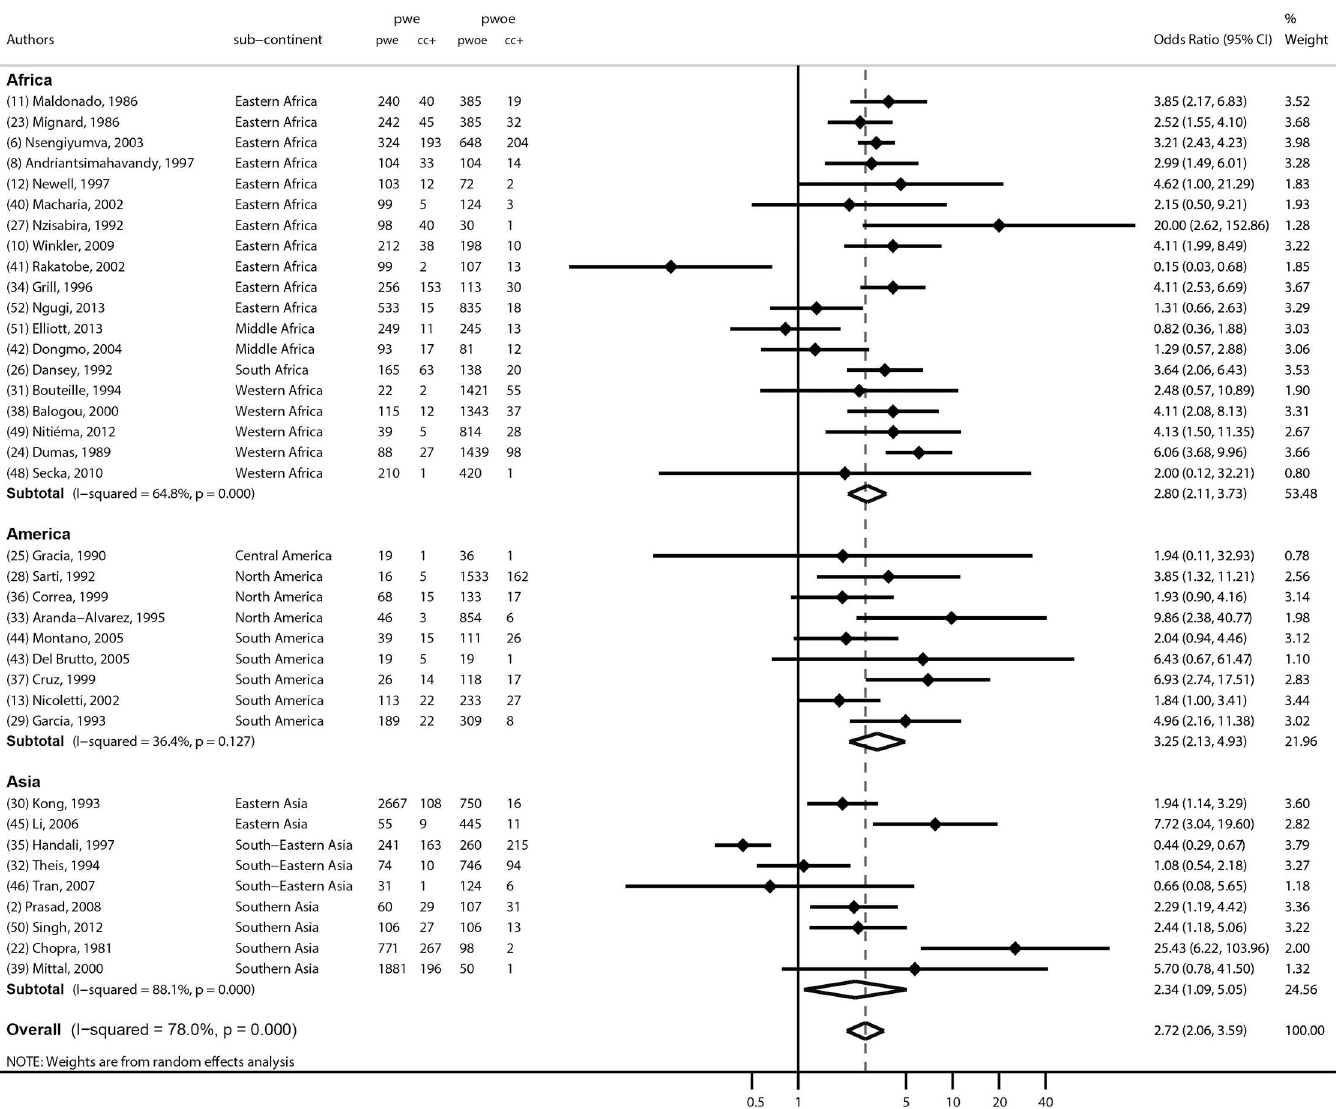
Fig 3. Meta-analysis assessing the association between CC and epilepsy globally and by continents: OR (odds ratio) of each study and common OR estimated using a random effectsmodel